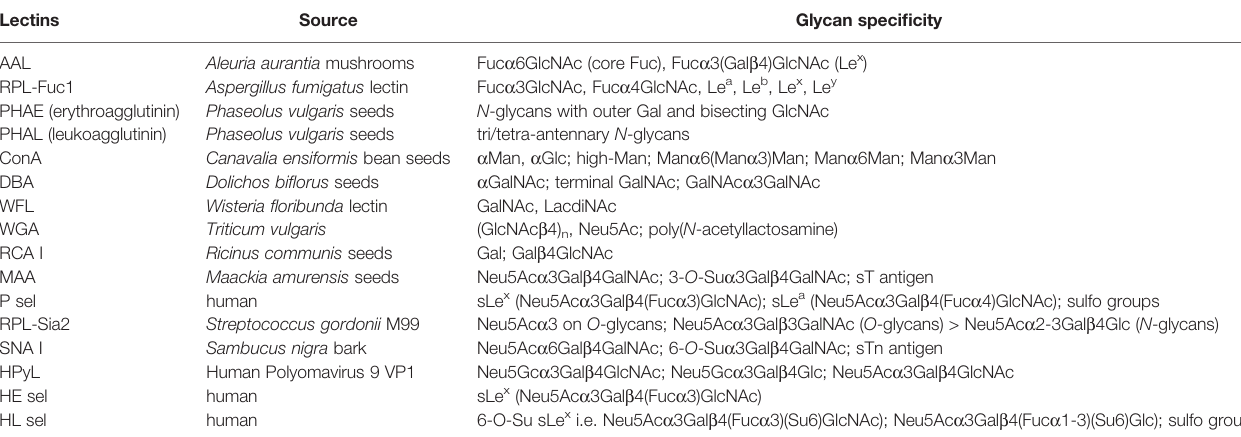
Table adapted from our previous study (41) with data taken from Vector Laboratories and GlycoDiag lea fl ets and from Refs (22, 25, 42 – 46).